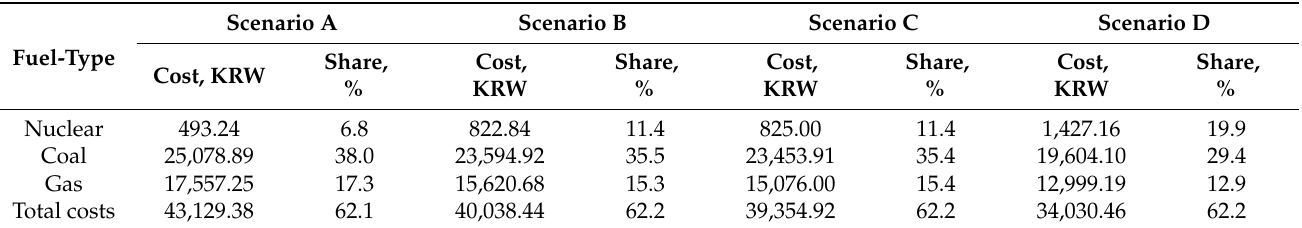
Table 8. Cost result of each